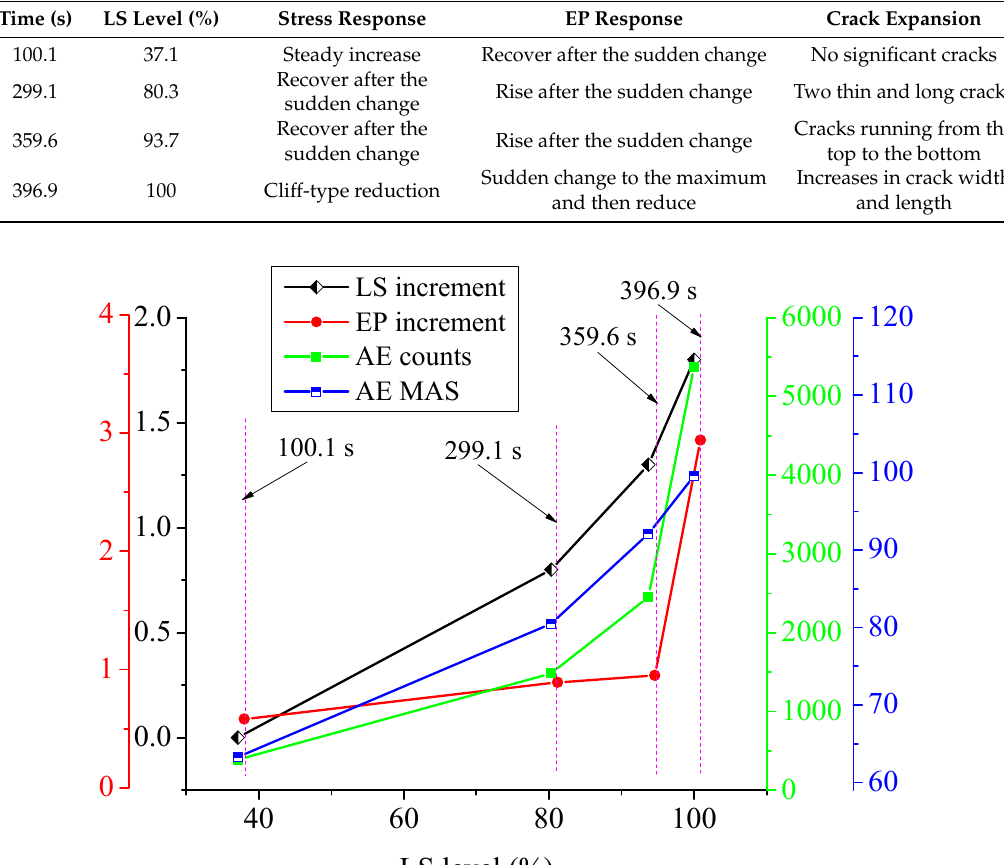
Figure 9. Datum statistics on EP and AE responses at different stress levels.